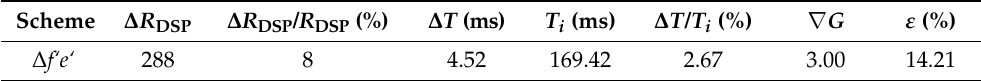
Table 9. ∇ G of schemes with different threads in coarse registration.